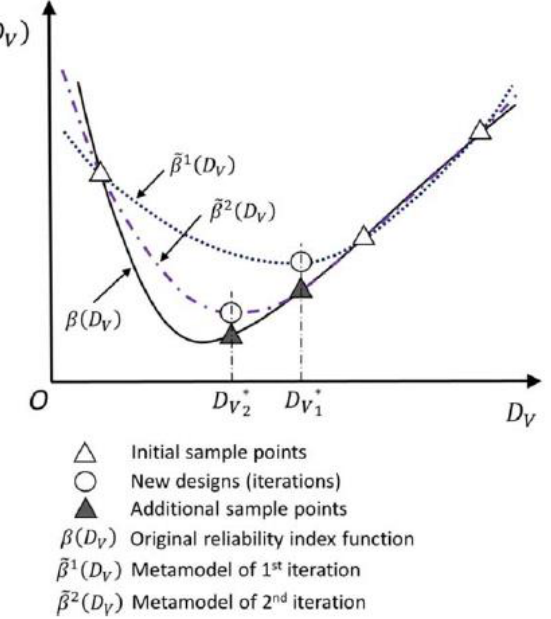
Figure 7. Adaptive metamodels of a reliability index function.